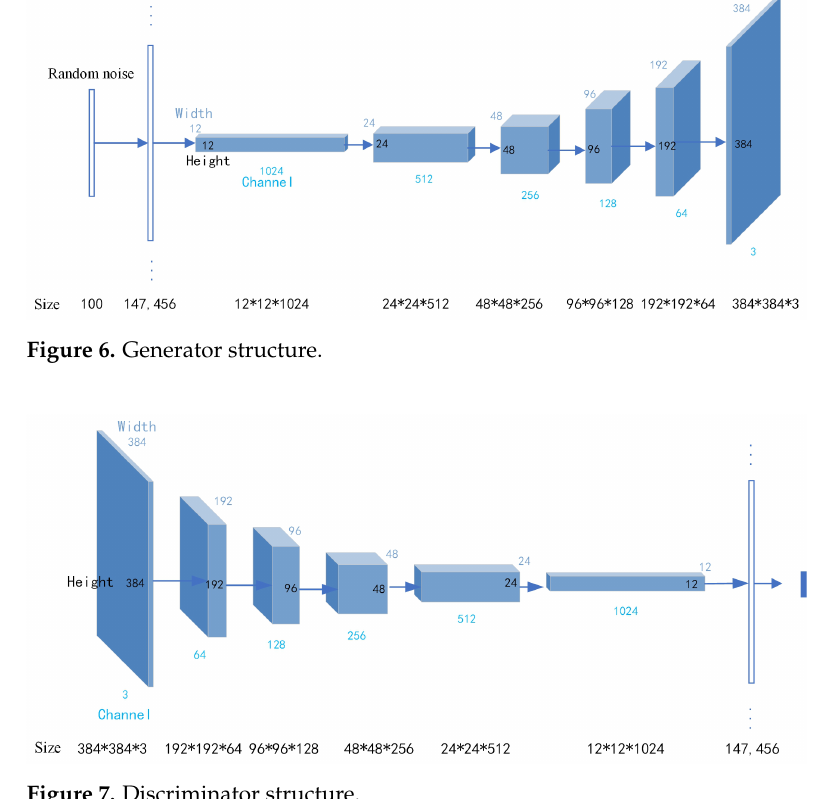
Figure 7. Discriminator